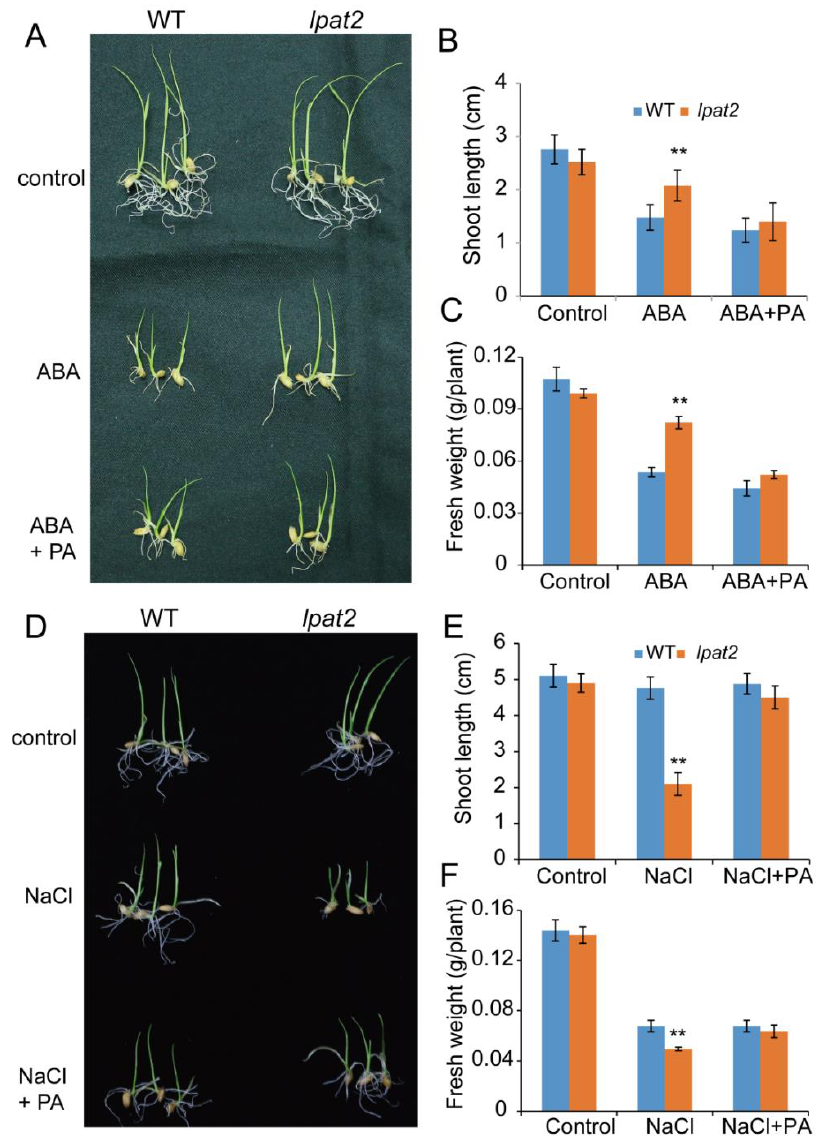
Figure 6. Exogenous PA application rescued the lpat2 mutant phenotype to WT in response to ABA and salt stress. ( A – C ) Exogenous PA application rescued the lpat2 mutant phenotype to WT in ABA response. Five-day-old seedlings were transferred to liquid medium without supplement (control), with 10 µ M ABA, and 10 µ M ABA + 20 µ g PA for one week. Values are means ± SD ( n = 10) from one of three independent experiments. ( D – F ) Exogenous PA application rescued the lpat2 mutant phenotype to WT in salt stress response. Five-day-old seedlings were transferred to liquid medium without supplement (control), with 100 mM NaCl, and 100 mM NaCl + 20 µ g PA for one week. Values are means ± SD ( n = 10) from one of three independent experiments. ** indicates significant difference at p < 0.01 compared with wild type (WT) based on Student’s t